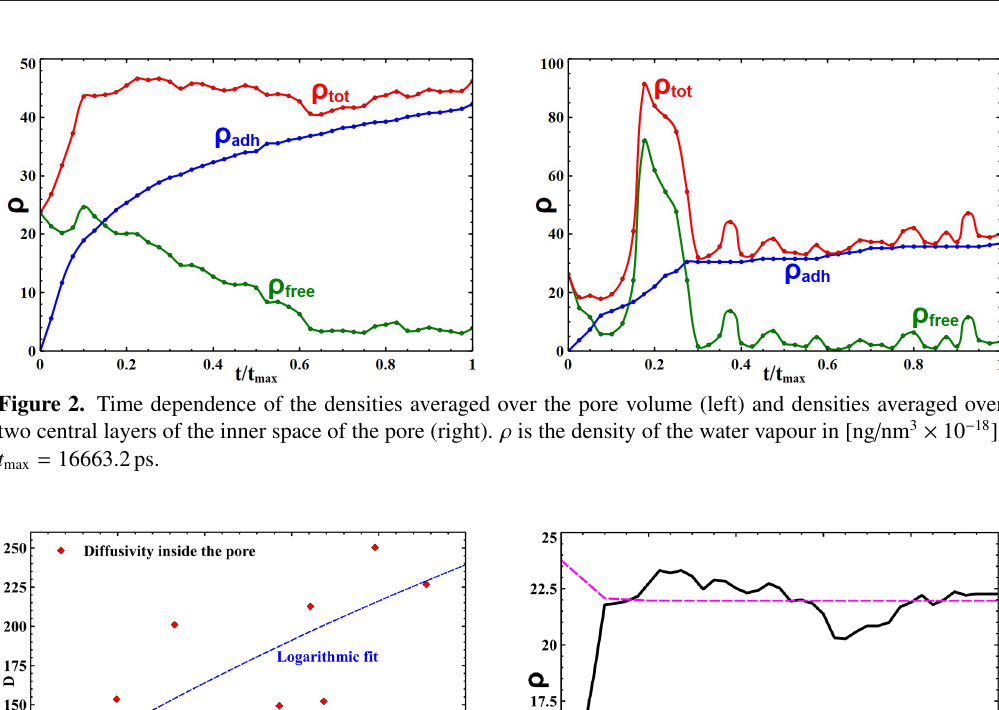
Figure 3. Approximation of the di ff usivity as a function of ρ by the logarithmic function (left). Comparison of the averaged density-curves calculated by the di ff usion equation with the logarithmic approximation of the di ff usivity and MD-curves (right). ρ is the density of the water vapour in [ng / nm 3